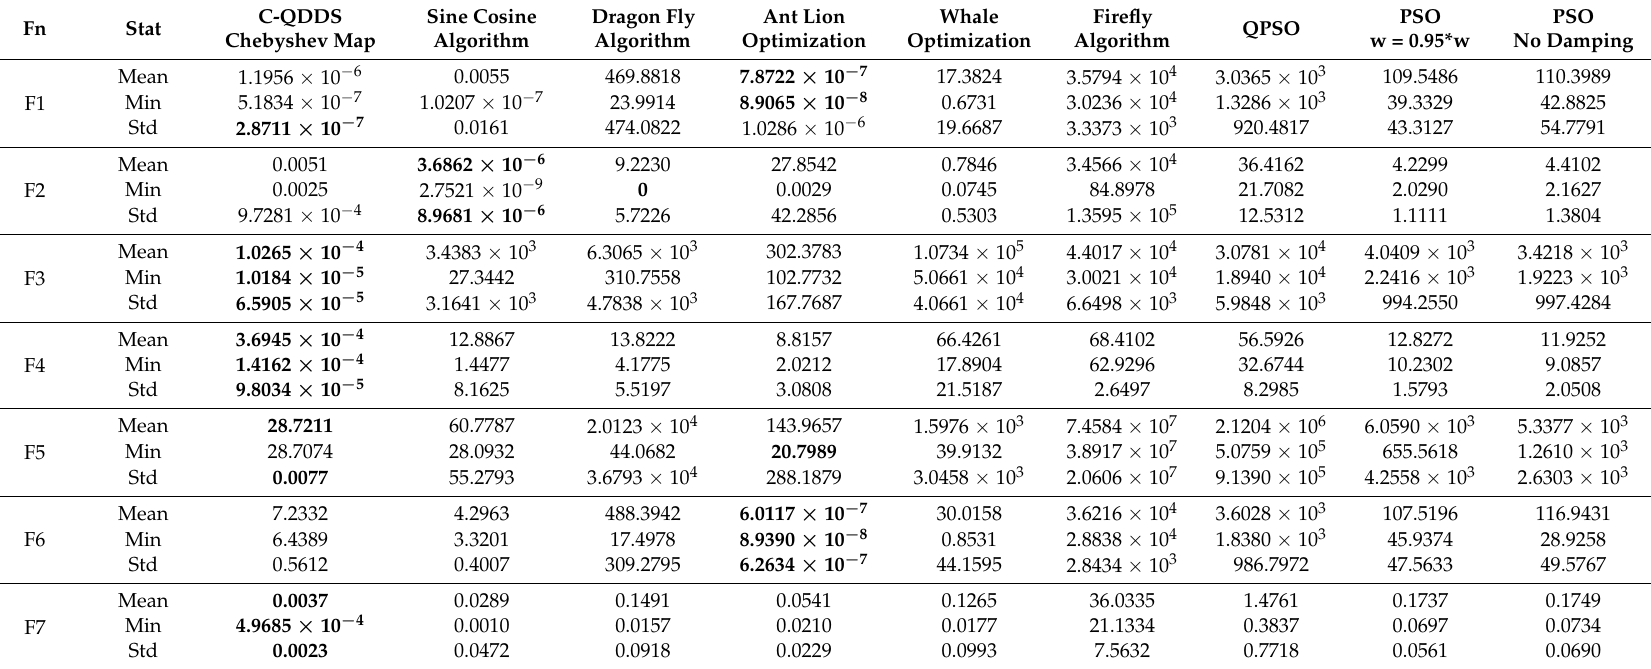
Table 10. Solution quality in unimodal functions in Table 2 (30D, 1000 iterations, 30 independent